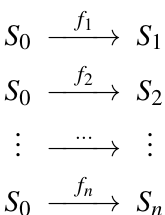
Figure 4. Quasiconformal diffeomorphic surface registration. ( a ) D on feature graph of S ( b ) D on dense mesh φ